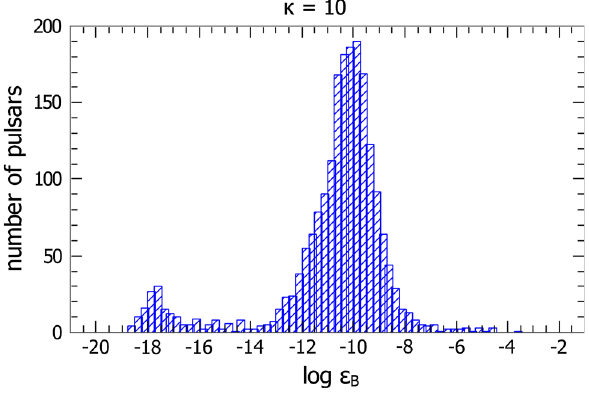
Fig. 3 Ellipticity histogram for the 1964 pulsars of Table 1 for k =